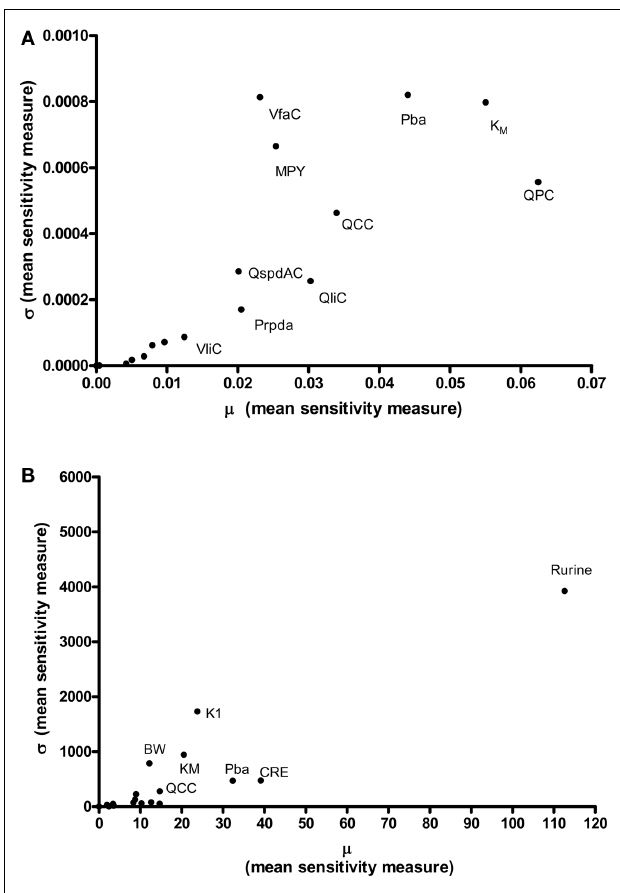
FIGURE 3 |The Morris Screening exercise. Results of the Morris Screening exercise for, (A) the concentration of m -xylene in venous blood (CV) and, (B) the urinary excretion of methylhippuric acid (expressed against creatinine) (C urine